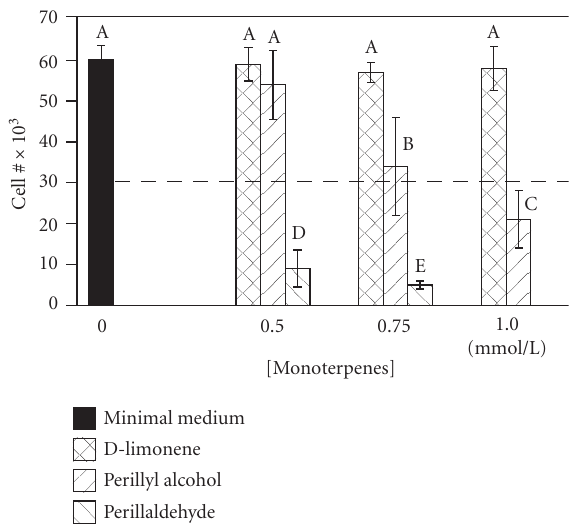
Figure 1. Monoterpenes exhibit varying degrees of inhibition of breast cell growth. MCF-10A cells were plated at 30 × 10 3 cells/well (dashed line) in serum-free minimal medium containing the indicated concentrations of monoterpenes, and counted 24 hours later. Bars represent mean ± stan- dard deviation ( n = 10). A student-Numan-Keuls test identified five groups (letters A–E; P ≤ . 05) which were statistically di ff erent from one another (ANOVA F:[9, 98] = 121.63, P < . 0001).